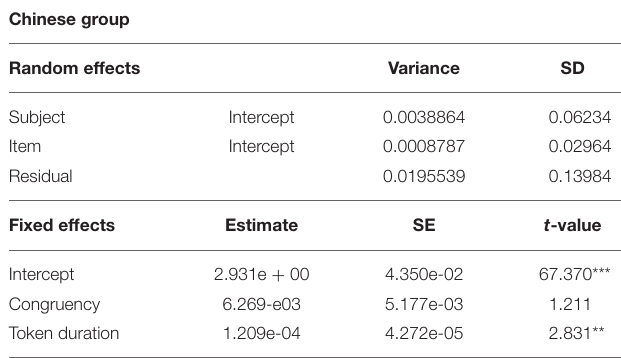
TABLE 5 | Results of the mixed-effects analysis for the Chinese